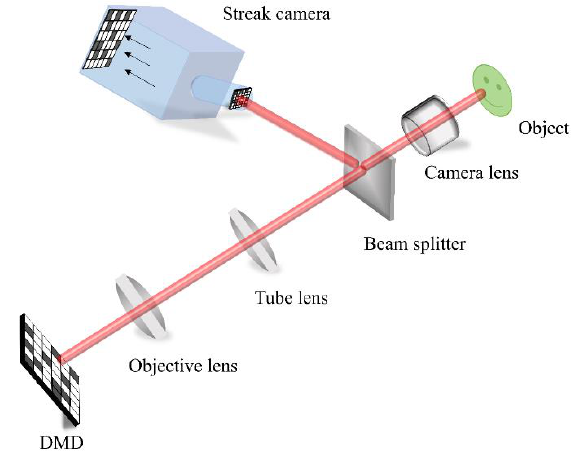
Figure 1. Schematic diagram of the original CUP system.